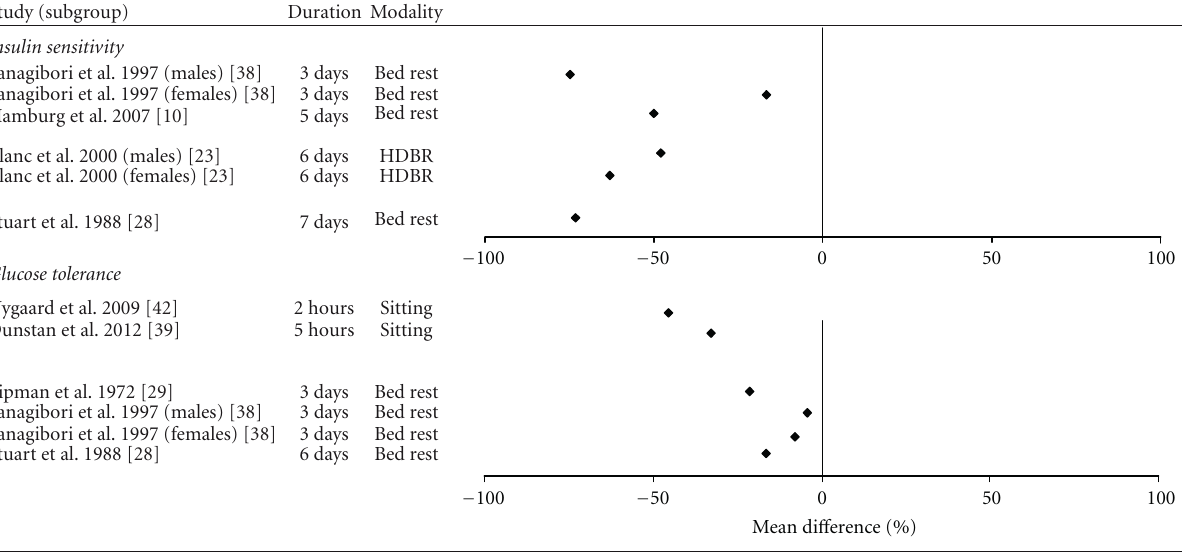
Figure 4: Forest plot of percent mean di ff erences of insulin sensitivity and glucose tolerance between sedentary behaviour and control conditions (sedentary